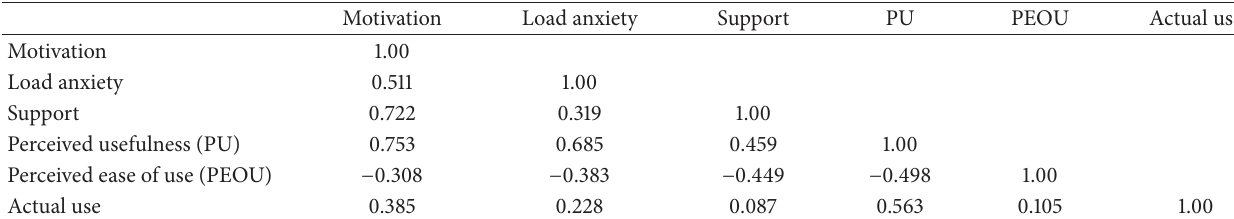
Table 3: Correlation matrix.